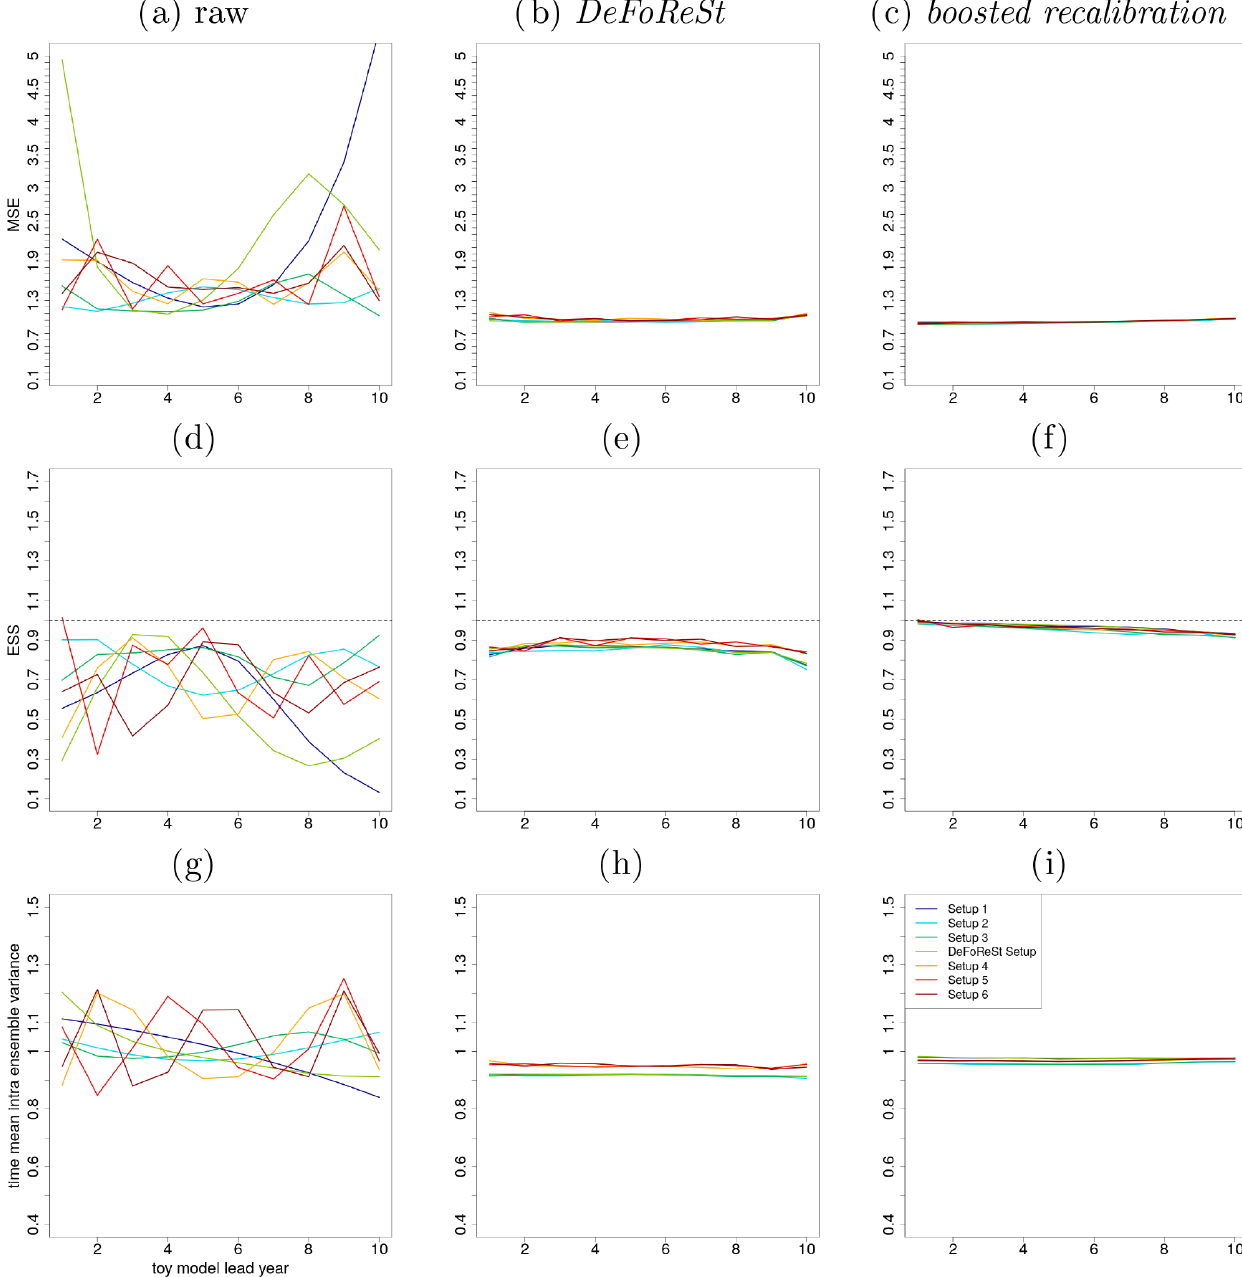
Figure 8. MSE of different toy model setups with high potential predictability ( η = 0 . 2, colored lines). (a) Raw pseudo-forecast, (b) post- processing with DeFoReSt and (c) post-processing with boosted recalibration. Panels (d) to (f) show the ESS and (g) to (i) the intra-ensemble variance (temporal average),